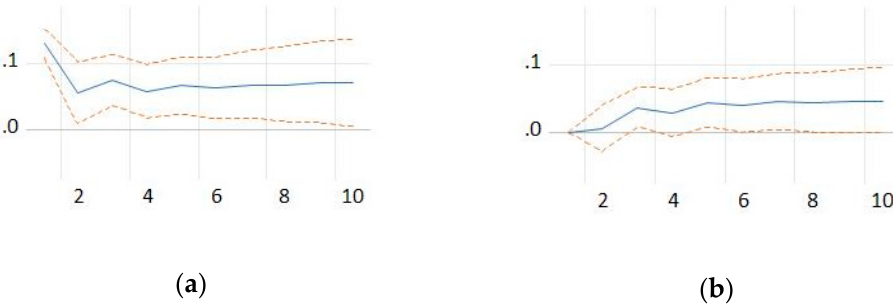
Figure 9. Response of persons employed in the population of deaths to a shock from: ( a ) persons employed in the population of deaths; and ( b ) persons employed in the population of births. Source: the authors’ own computations.